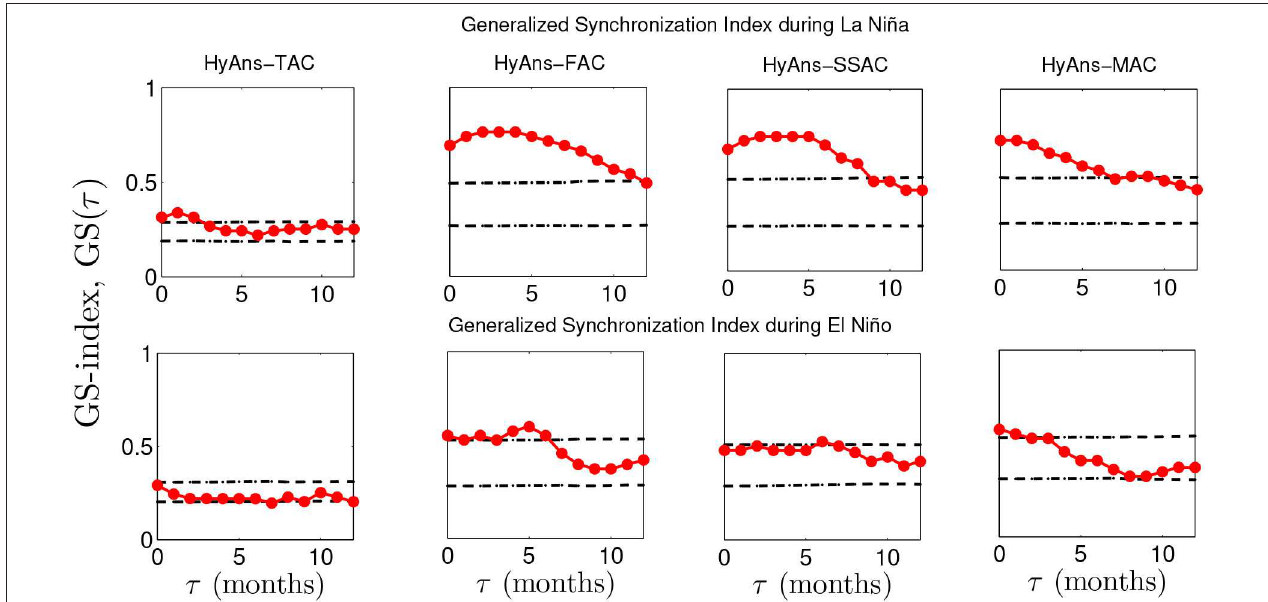
FIGURE 8 | Generalized synchronization index (GS-index) between the ENSO signal (MEI index) and monthly rainfall anomalies in the Andean region estimated using the four HyAns methods: HyAns–TAC, HyAns–FAC, HyAns–SSAC, HyAns–MAC. (Top row) La Niña and (bottom row) El Niño. Period 1976–2015. τ denotes the time lag. (Dashed black lines) 95% confidence